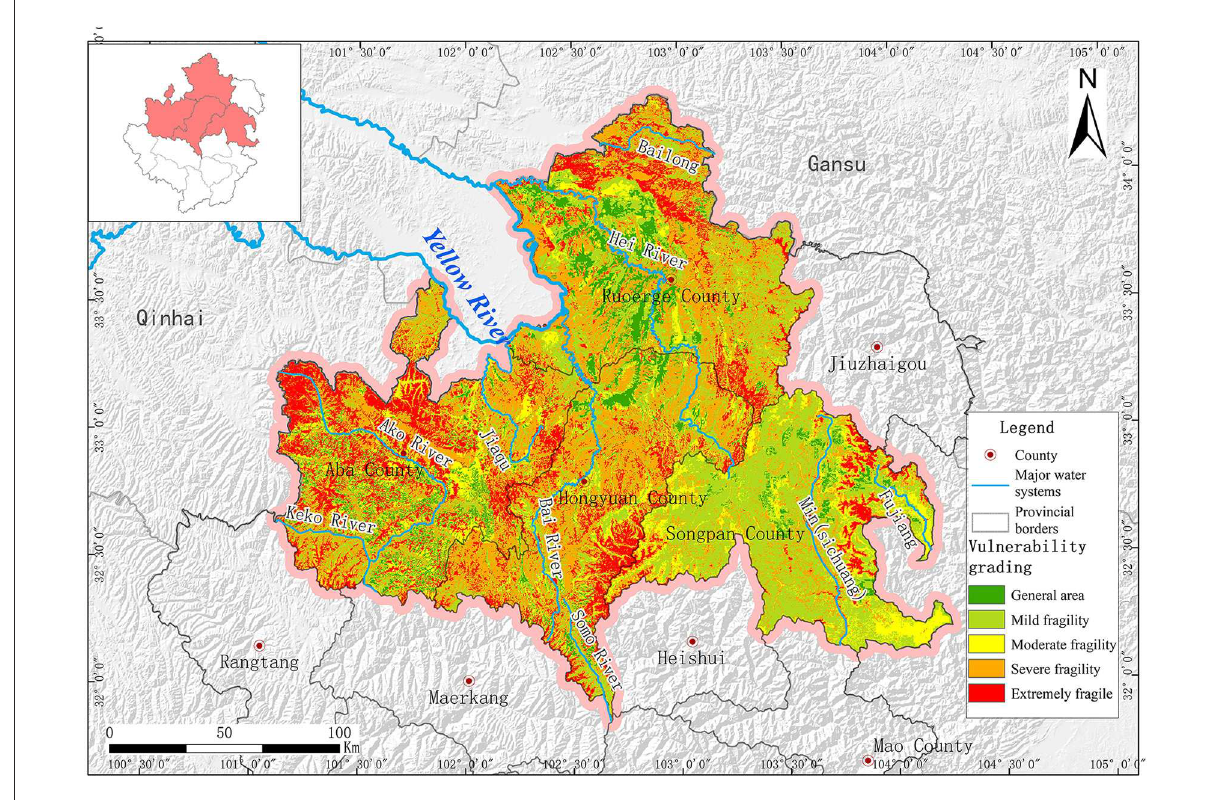
FIGURE12 Ecological vulnerability